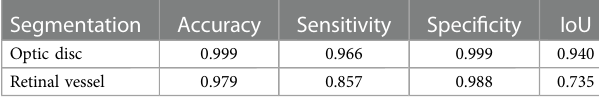
TABLE 1 Performance of ResUNet on segmentation of optic disc and retinal